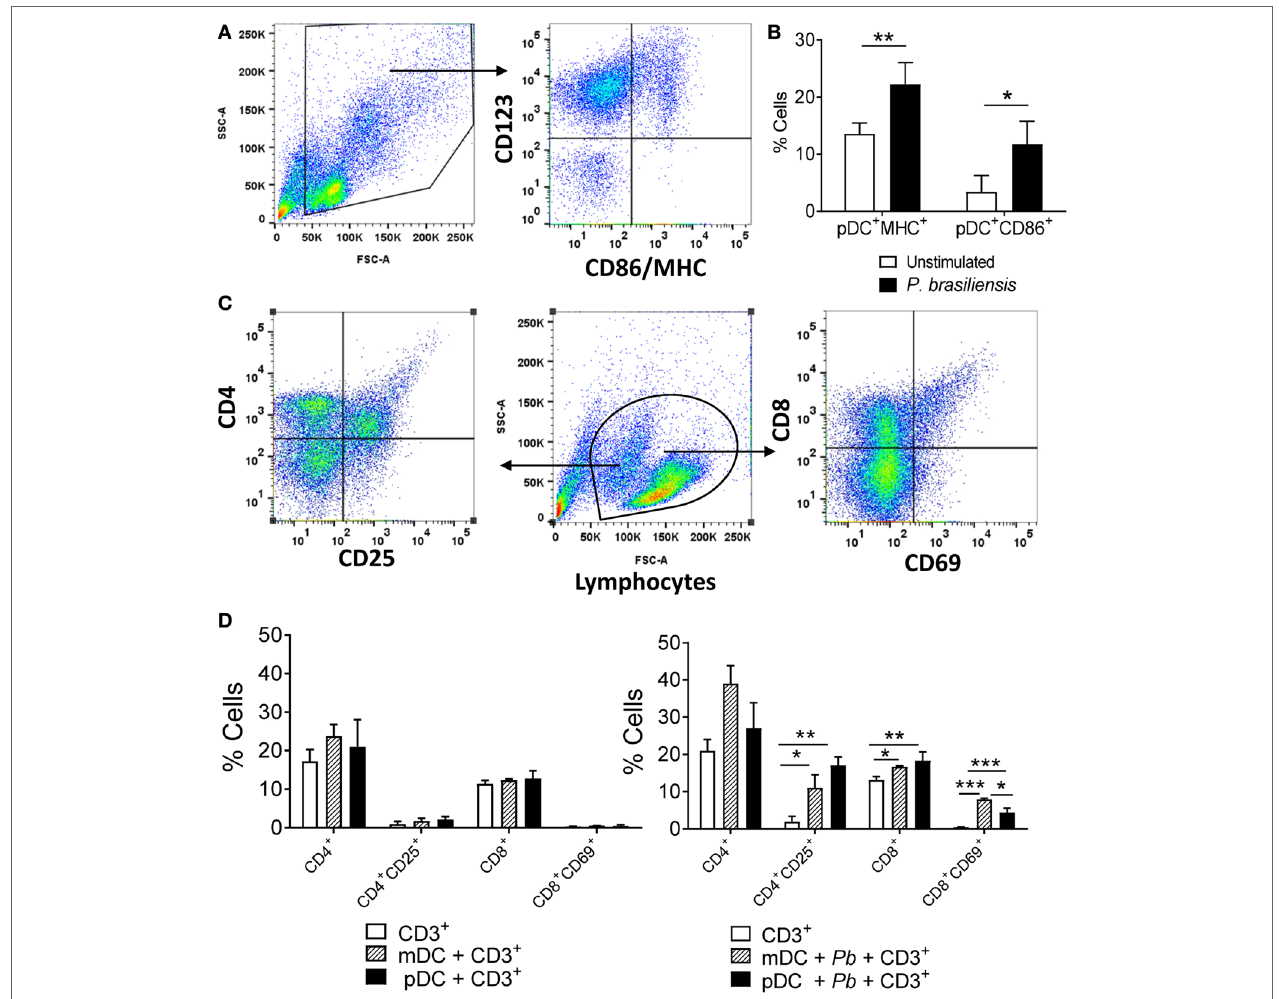
FigUre 9 | Paracoccidioides brasiliensis stimulation induces a mature phenotype in plasmacytoid dendritic cells (pDCs) that become able to promote the activation of CD4 + and CD8 + T lymphocytes. Peripheral blood mononuclear cells (PBMCs) were separated into pDC-positive (pDCs + ) and myeloid dendritic cell (mDC)-positive (mDC + ) population using magnetic beads conjugated to anti-CD304 and anti-CD1c antibodies, respectively. (a,B) For characterization of pDCs activation, the cells were labeled with appropriate titers of anti-CD123, MHC-class II, and CD86 antibodies and then 50,000 events were acquired in the flow cytometer and gated as indicated in the dot plots (a) . As the pDC + population was stained with an specific pDC marker (anti-CD123), the characterization of cell maturation was performed by obtaining the pDCs from the PBMCs following one round of positive selection. Data are the means ± SE of the frequency of double-positive cells from three donors, tested in triplicate (B). (c,D) For coculture experiments, the pDCs and mDCs (1 × 10 5 /well) were cultured with or without P. brasiliensis yeast cells (1 × 10 4 ) and after 2 h they were then placed in cocultured with lymphocytes (1 × 10 6 ), which were previously obtained from PBMCs of the same donor and separated with anti-CD3 magnetic beads. After 5 days of coculture, the lymphocytes were analyzed by flow cytometry using anti-CD4, CD8, CD25, and anti-CD69 antibodies. The control wells contained only CD3 + cells. The lymphocyte population was gated by FSC/SSC analysis and the gated cells were then analyzed for expression of lymphocyte activation markers (c). Data are the means ± SE of the frequency of single positive (CD4 + /CD8 + ) double-positive cells (CD4 + CD25 + and CD8 + CD69 + ) from three donors, tested in triplicate in cultures with [ (D) , right panel] or without P. brasiliensis yeast cells [ (D) , left panel]. * p < 0.05, ** p < 0.01, *** p < 0.001 by comparing the data indicated by the